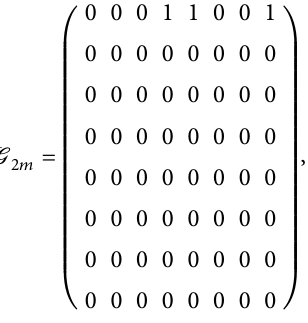
nization, namely, (1) achieves quasi-synchronization based on observers. Take α 0, β 2, and ς 0 . 8. (cid:31) (cid:31) Under quasi-synchronization, the state diagram of 8 nodes of (1) and (2) when α 0 . 2 is shown in Figure 4. > (cid:31) Under synchronization, the state diagram of 8 nodes of (1) and (2) when α 0 is shown in Figure 5. (cid:31)